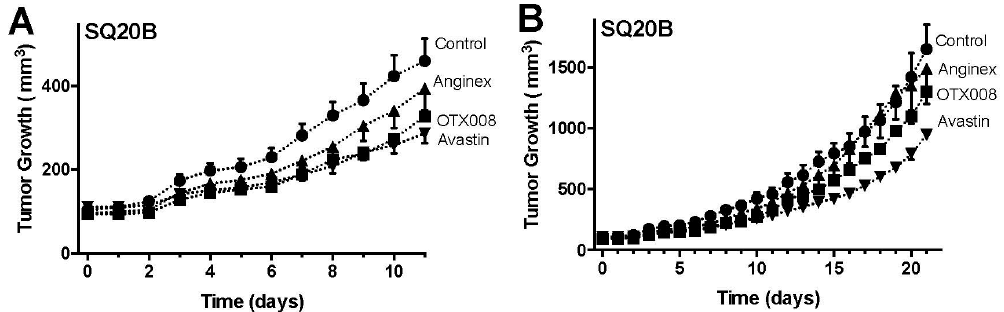
Figure 2. OTX008 inhibits SQ20B tumor growth in mice. ( A ) SQ20B tumor growth during the first 11 days and treatment with Control (vehicle), Anginex, OTX008 and Avastin; ( B ) SQ20B tumor growth during the whole treatment span with Control (vehicle), Anginex, OTX008 and Avastin. Treatments: Control (vehicle; - -), Anginex (i.p. 10 mg/kg, q1d×21; n = 7; - -), OTX008 (i.p. 10 mg/kg, q1d×21; n = 7; - -), and Avastin (i.v. 10 mg/kg, q14d×2; n = 7; - -). Data points represent means ± SEM ( n = 7 each group).